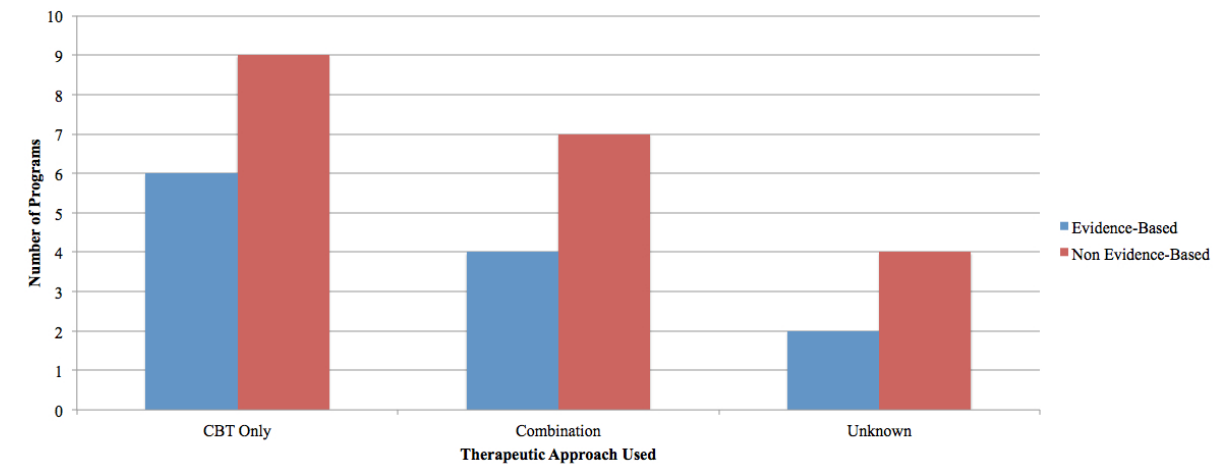
Figure 5. Therapeutic approach offered in programs evaluated.